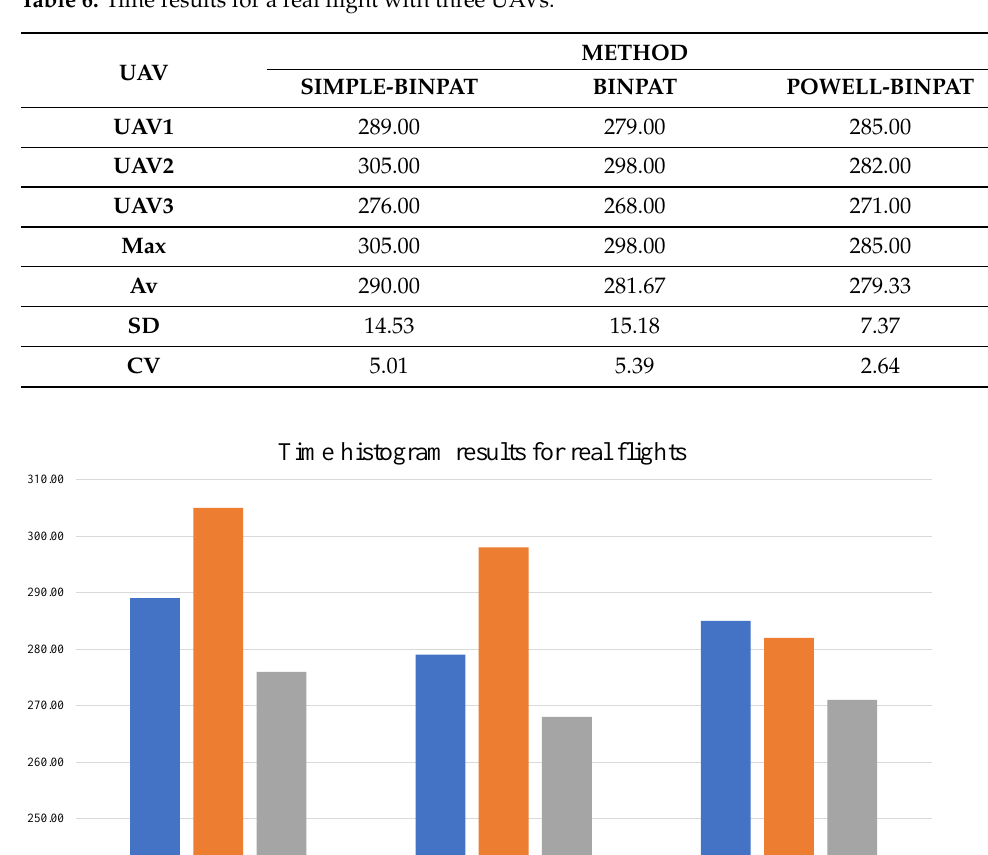
Table 6. Time results for a real flight with three UAVs.